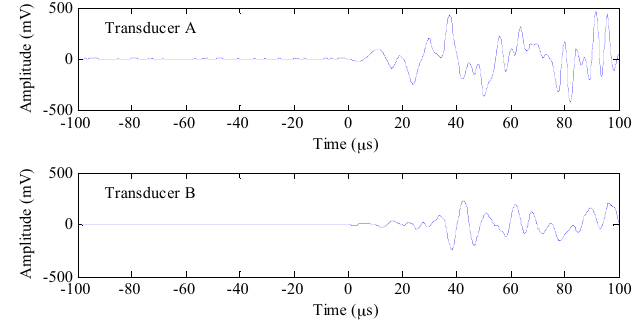
Figure 5. Waveforms from pencil lead break tests for both transducers.